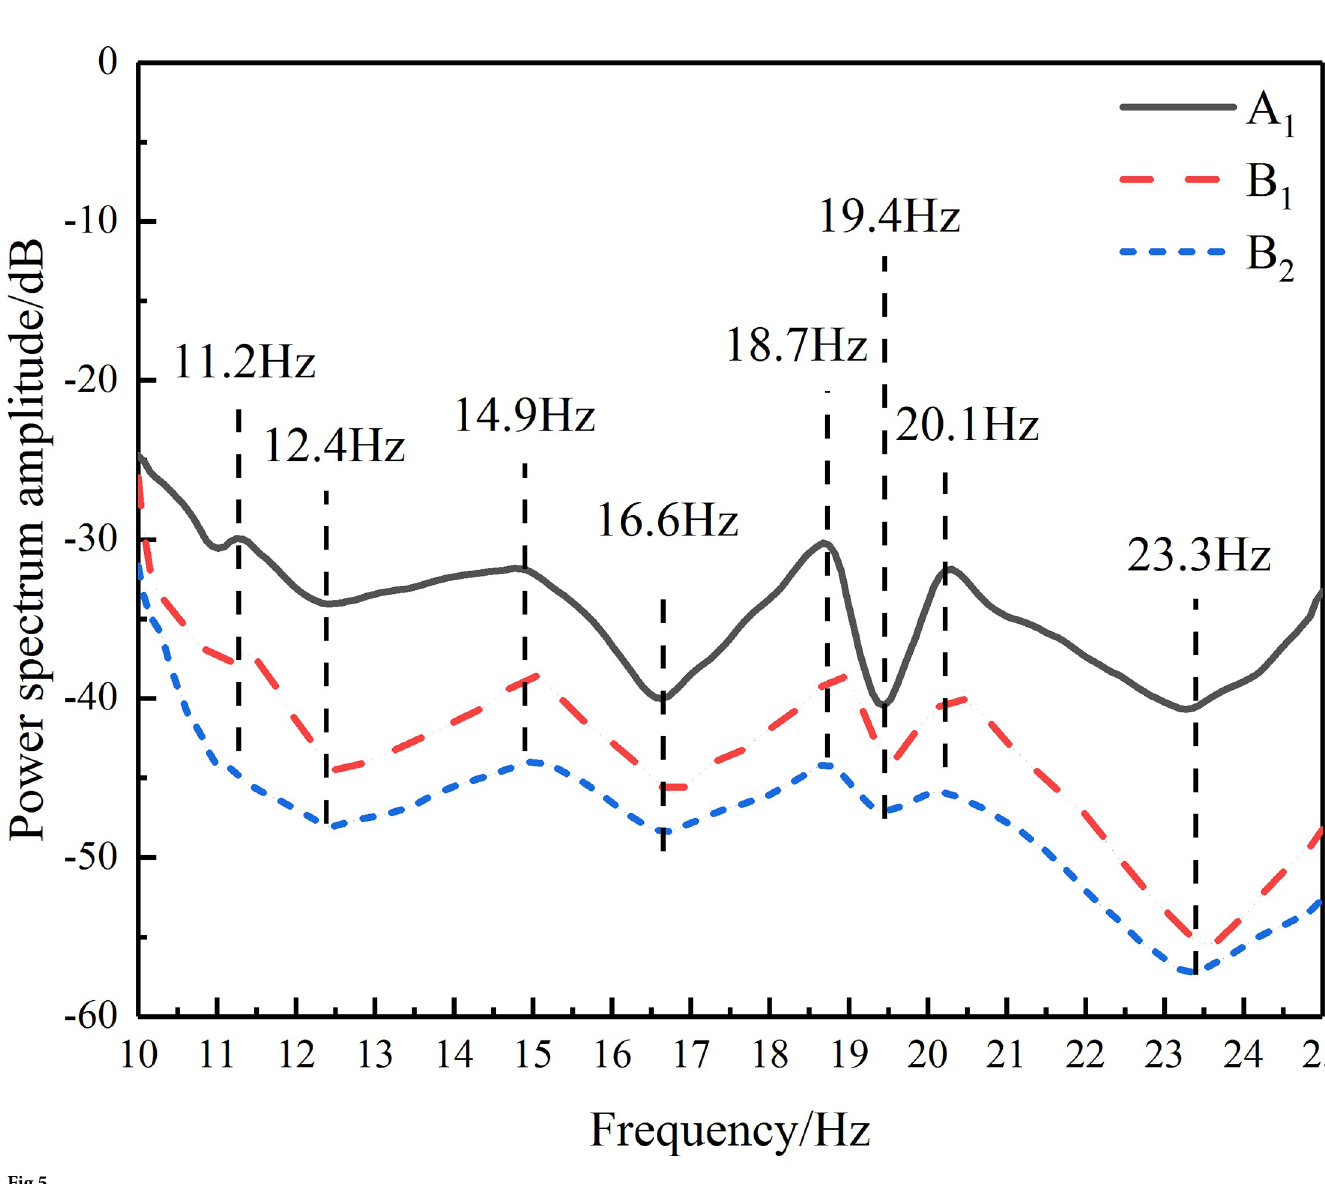
of the branch. The resonant frequencies of B and B were very similar to the resonant frequen- 1 2 cies of points C and C , respectively. Therefore, the acceleration response at different charac- 1 2 teristic frequencies was only tested at the branching points B and B of the secondary 1 2 branches. During the acceleration response experiments, there was only one simulated fruit at the location of the test point B and B . The results of the test have been shown in Table 3. 1 2 For test point B , the acceleration response values of the X , Y , and Z directions were differ- 1 ent for each frequency. The acceleration response value in the X direction was the largest, the value in the Y direction was larger except at 16.6 Hz, and the value in the Z direction was much smaller than those of both the X and Y directions. For example, when the excitation fre- quency was 11.2 Hz, the acceleration value in the Z direction was only 5.51 m/s 2 , while the acceleration values in the X direction and Y direction were 5.16 times and 3.32 times of that in